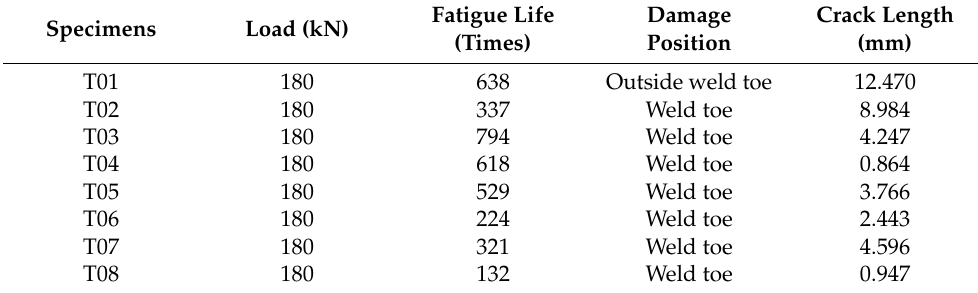
Table 6. Test results of T-type tube